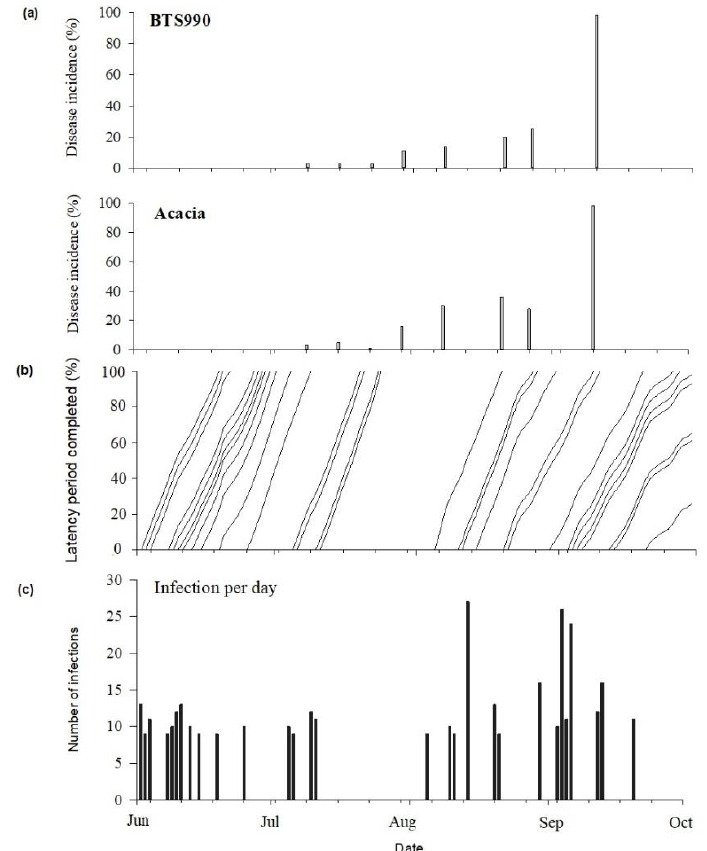
Figure 10. Measured incidence of Cercospora leaf spot ( a ), simulated latency period ( b ), and simu- lated Cercospora beticola infection events on sugar beet ( c ) at Perwez during the 2018 cropping season. Infection periods were simulated using the weather-based model #1 (see Table 4). The cultivars BTS990 and Acacia have a susceptibility to CLS of 6 (moderately resistant) and 4 (sensitive), respec- tively [30].